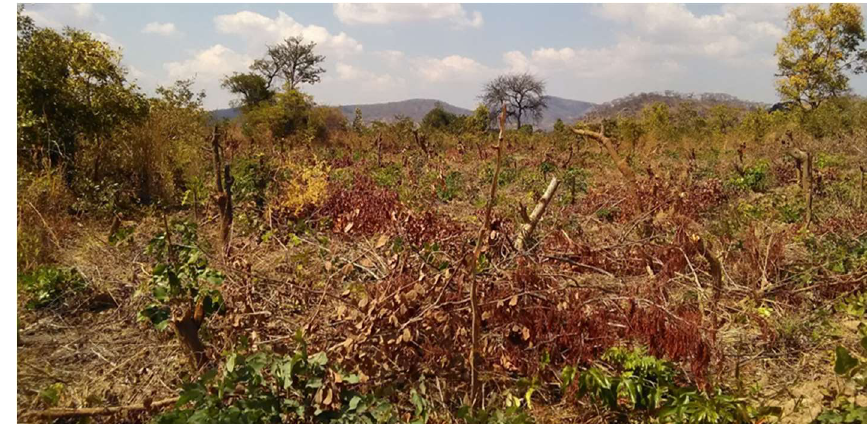
Figure 4. Land being cleared for farming (Photo by Teiji Watanabe, 7 August 2017).